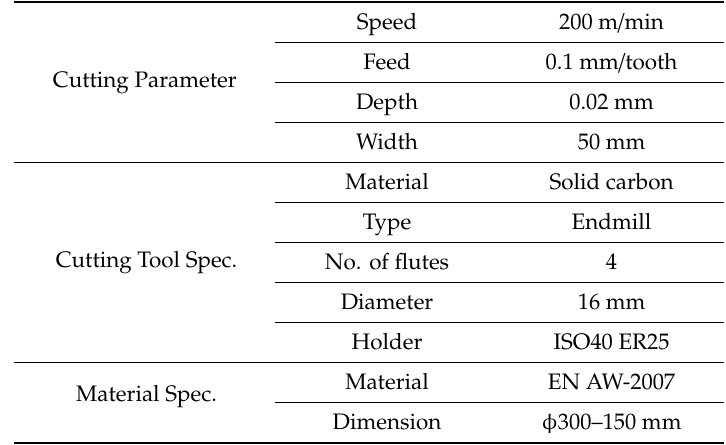
Figure 3. ( a ) Workpiece diagram and ( b ) representation. Table 2. Cutting test parameters.